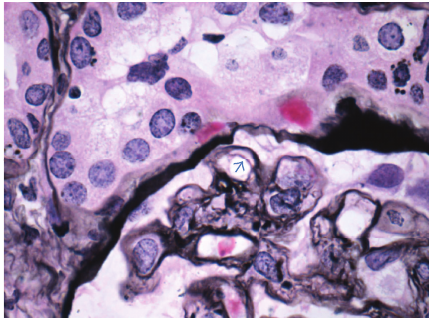
Figure 4: Duplication of the GBM is present in some glomerular capillary loops (green arrow) (Jones methenamine silver